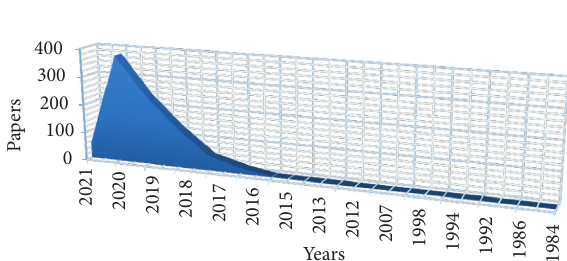
Figure 10: Years and